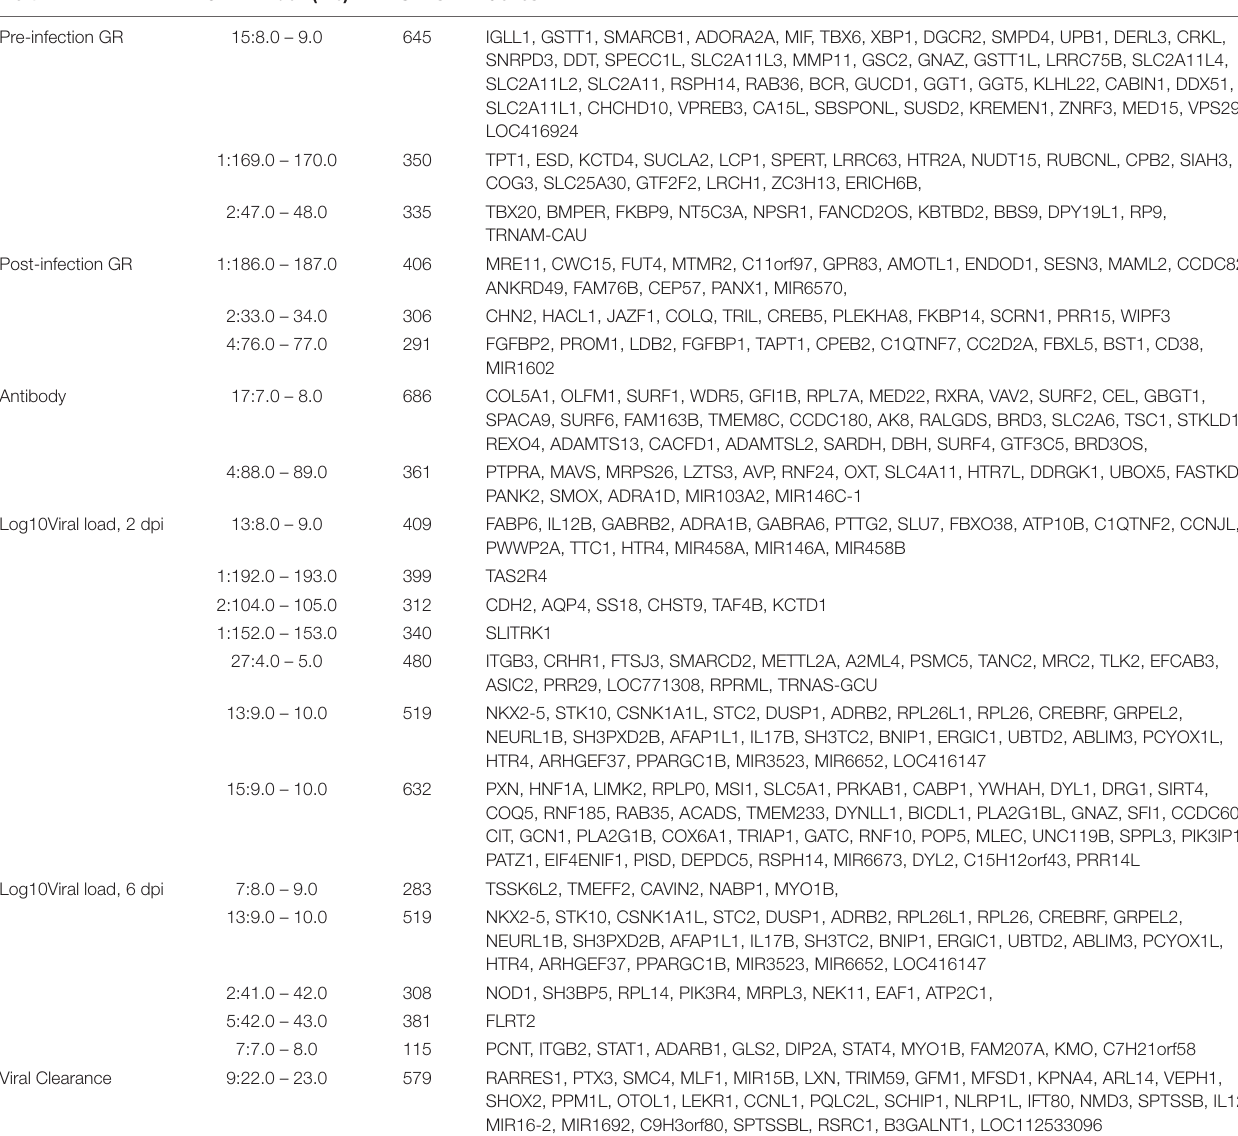
TABLE 6 | Genes located in 1-Mb windows with ≥ 1% of genetic variance for NDV response traits in the Ghana local chicken ecotypes population.